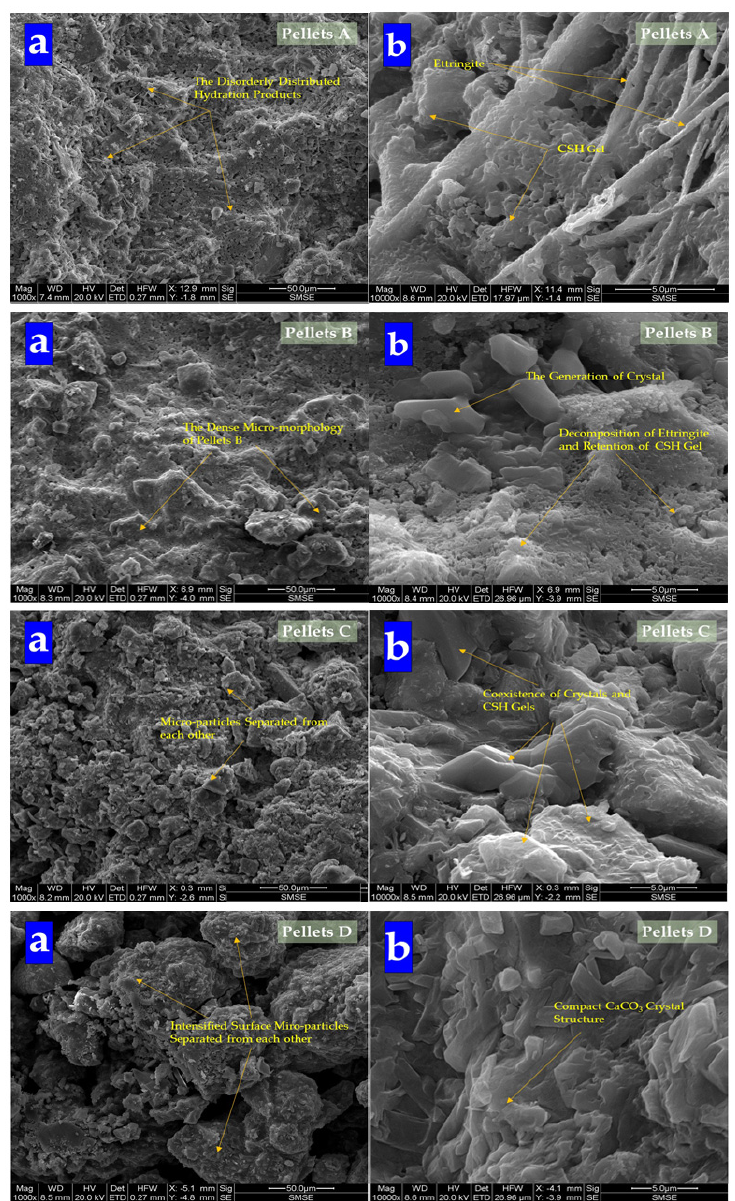
Figure 9. SEM analysis of CHPs. ( a ) Morphology at 50 μ m; ( b ) morphology at 5 μ m.